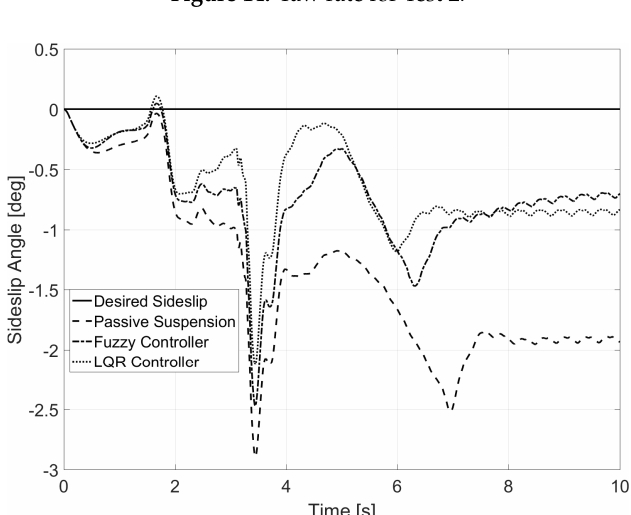
Figure 15. Sideslip for Test